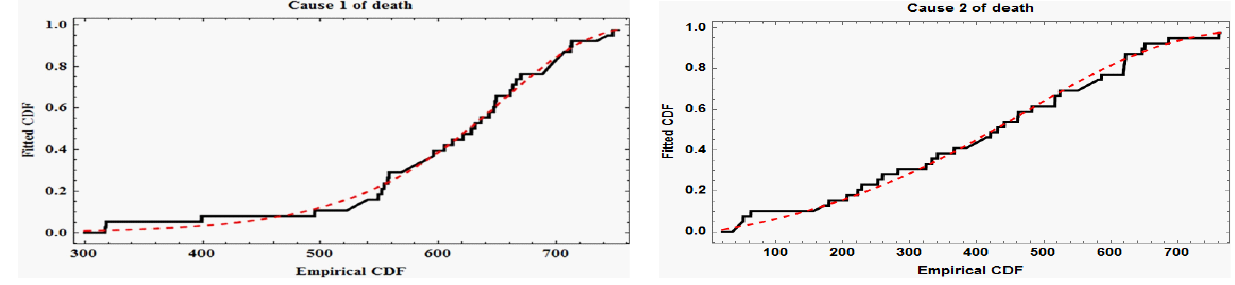
Figure 1. Empirical cumulative distribution functions (Black lines) and fitted parametric cumulative Fig. 1. Empirical cumulative distribution functions (Black lines) and (cid:133)tted parametric cumulative distribution functions (red dashed lines) distribution functions (red dashed lines) for the data from Hoel (1972). Panels ( a , b ) represent the for the data from Hoel (1972). Panels (a) and (b) represent the cause 1.and cause 2 of death, respectively. cause 1 and cause 2 of death, respectively.